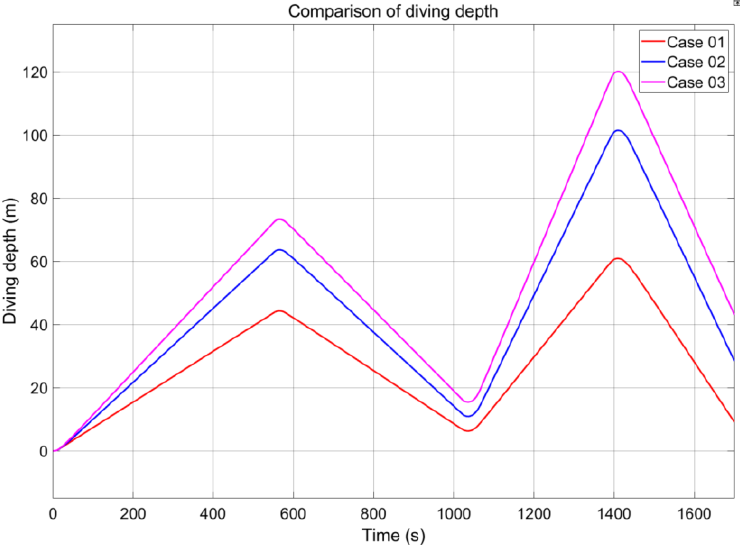
Figure 15. Comparison of diving depth.